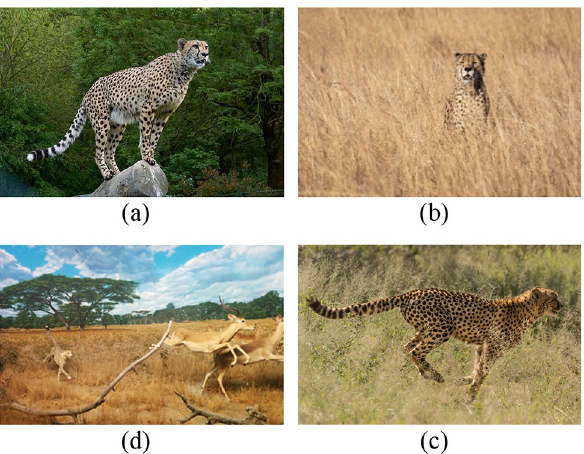
Figure 1. Hunting behavior of cheetahs: ( a ) searching for prey (scanning mode), ( b ) sitting-and-waiting (hiding), ( c ) rushing and ( d )